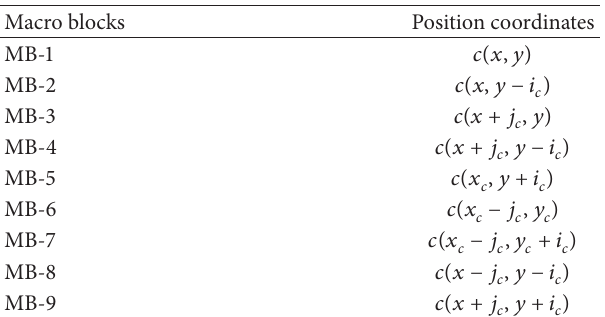
Table 4: Position coordinates of vertex macroblock with oblique